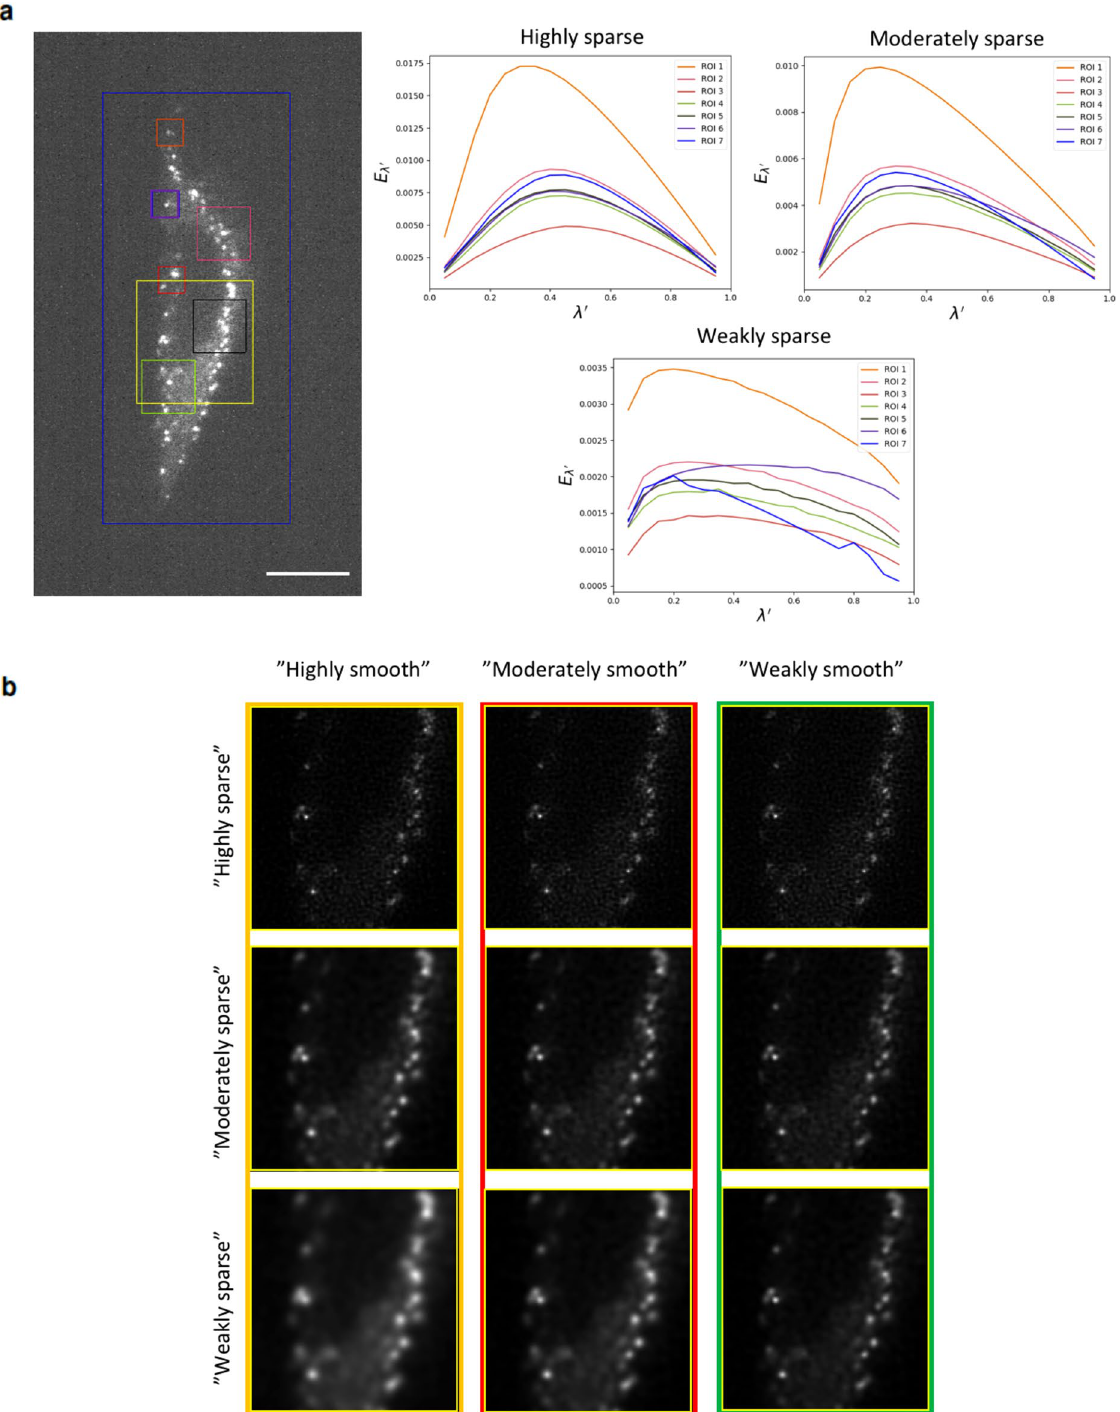
Figure 6. Selection of regularization and sparsity parameters. ( a ) Display of square ROIs with variable sizes superimposed on single X-Y slide of 3D LLSM image depicting σ subunit-eGFP of the AP2 complex in Hela cells (left). Scale bar: 10 µ m. Illustrations of energies E (cid:31) ′ ( f , u ) with respect to (cid:31) ′ ∈] 0, 1 [ for different ROIs, and ∗ three levels (“weak”, “moderate”, “high”) of sparsity. The minimax value (cid:31) ′ is in the interval [0.2, 0.4] according to the sparsity level in all ROIs, suggesting that the maximum is invariant to scale (right). ( b ) Display of the 3 × 3 matrix associated to the yellow ROI (see ( a ), left) whose the rows and columns represent smoothness ∗ and sparsity. The default value (cid:31) ′ = 1 / 2 corresponds to matrix cells marked in red. The minimax value (cid:31) ′ corresponds matrix cells marked in orange. We also display the “symmetric” solution corresponding to (cid:31) ′ = 1 − (cid:31) ′ ∗ (matrix cells marked in